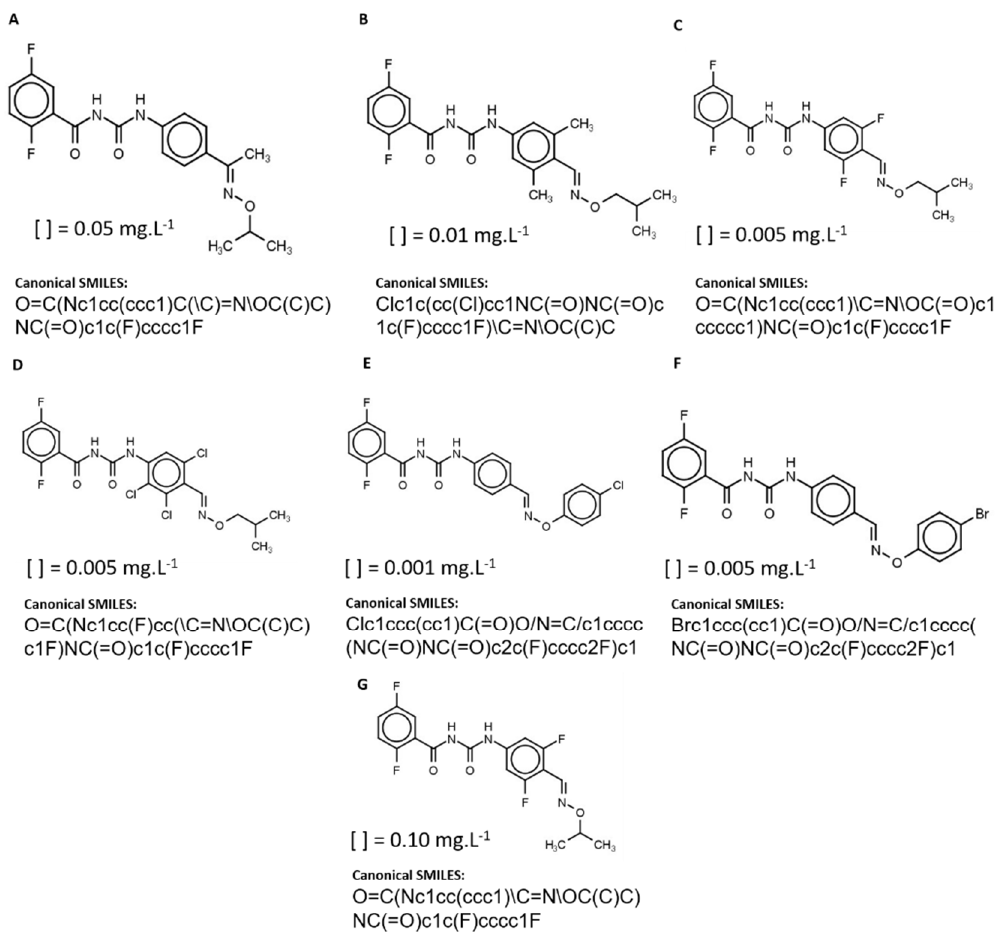
Figure 19. Structures of selected training set compounds, with canonical smiles and concentrations ([ ]) with 100% larvicidal activity (mg·L −1 ). ( A )—Compound 01 ; ( B )—Compound 05 ; ( C )—Compound 06 ; ( D )—Compound 07 ; ( E )—Compound 12 ; ( F )—Compound 13 ; ( G )—Compound 16 .